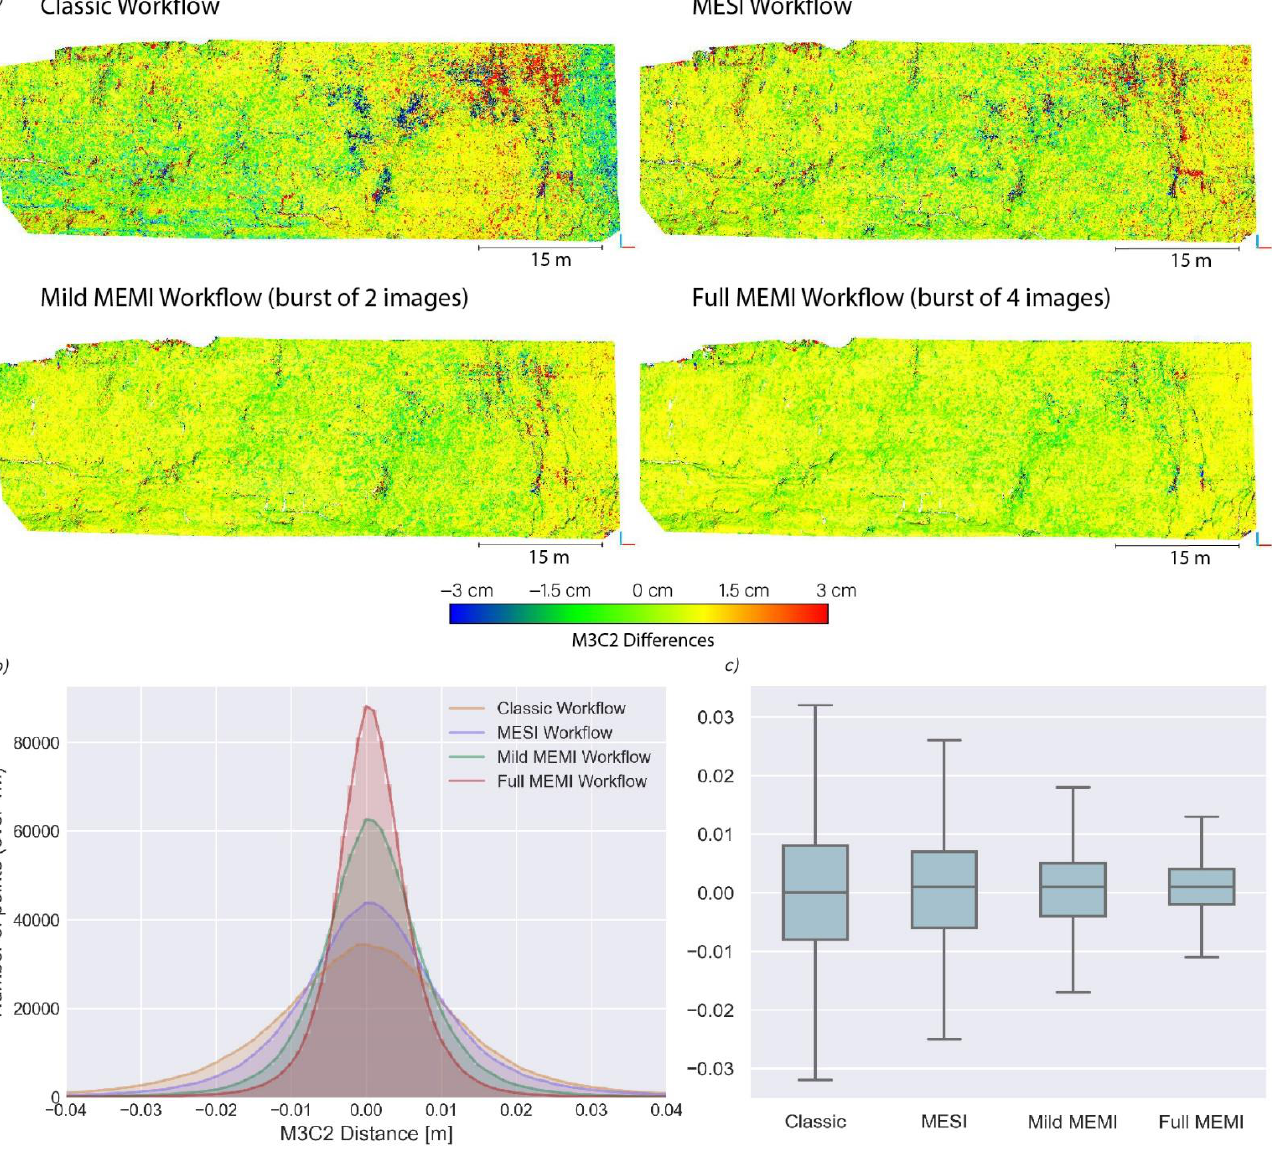
Figure 7. ( a ) Graphic representation of the differences between the models of May 23 and 24, according to the workflow used. The four models are represented using the same colour scale. ( b ) Histogram with the M3C2 results. ( c ) Error bar plot with the dispersion of the values obtained in each comparison. This can be observed in the maps of differences (Figure 7a) and in the histograms (Figure 7b) obtained using the May 2020 images. The smallest differences between the two compared days were achieved with the MEMI workflow using four images (full MEMI workflow). The standard deviation of the M3C2 differences decreased by 50%, from 3.37 cm in the classic workflow to 1.68 cm in the full MEMI workflow. The boxplots (Figure